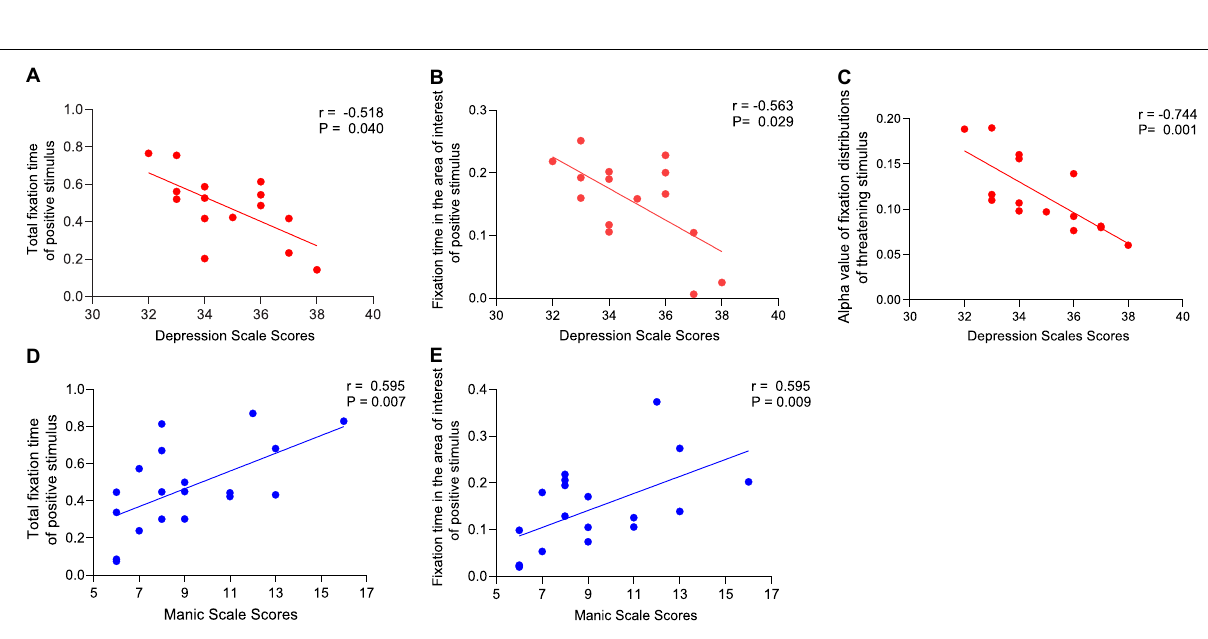
FIGURE 4 | Correlation analysis between scale scores (depression scale scores and manic scale scores) and eye-tracking measures [total fixation time, area of interest (AOI) fixation time, and alpha value of fixation distributions]. Correlations between depression scale scores and (A) total fixation time of positive stimulus, (B) fixation time in the area of interest of positive stimulus, (C) alpha value of fixation distributions of threatening stimulus. Correlations between manic scale scores and (D) total fixation time of positive stimulus, (E) fixation time in the area of interest of positive stimulus. The correlation coefficient (r) and significance value (p) are also shown in each case. All the correlations are statistically